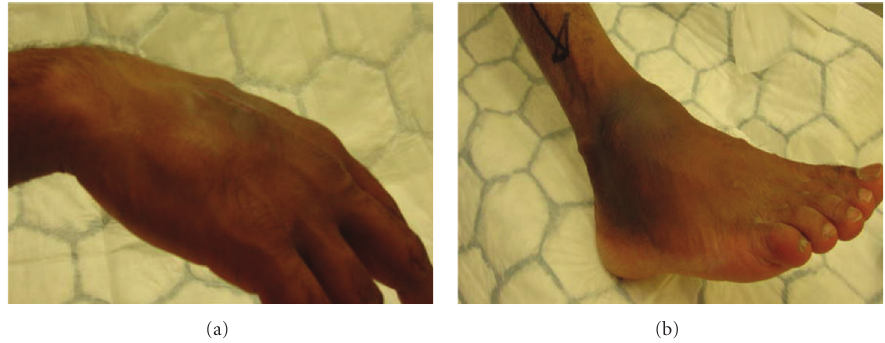
Figure 1: Nodular appearance of right dorsal hand swelling (a) and foot (b).